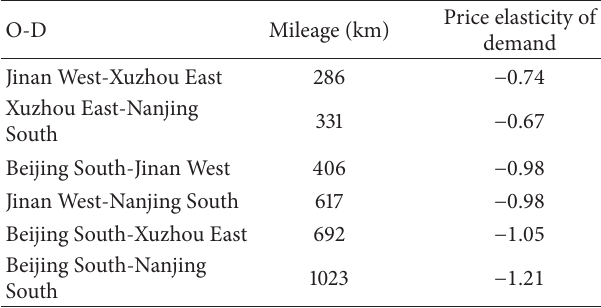
Table 1: Estimates for price elasticity of